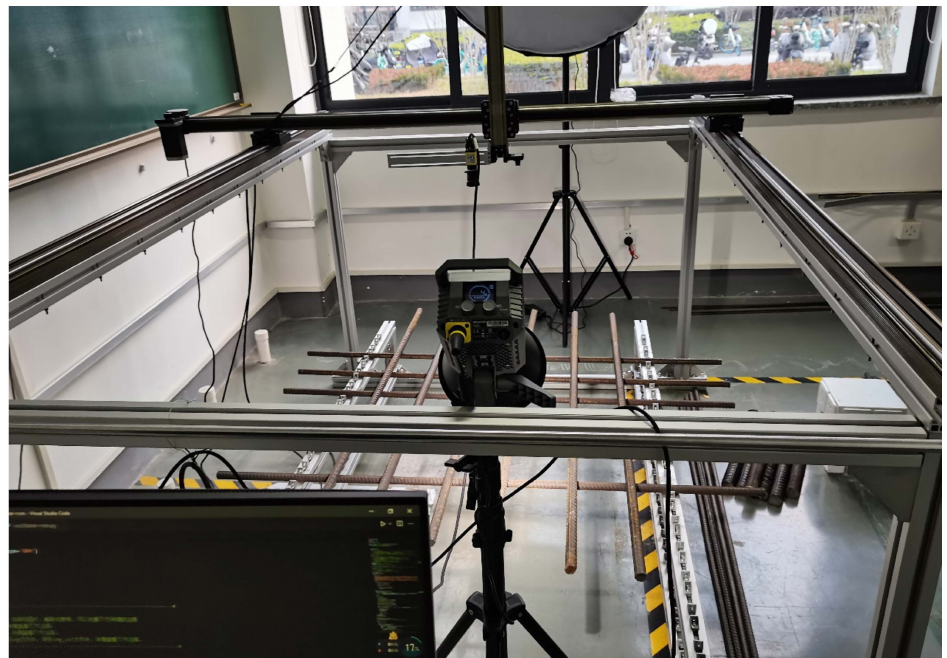
Figure 11. Real photograph of the acquisition